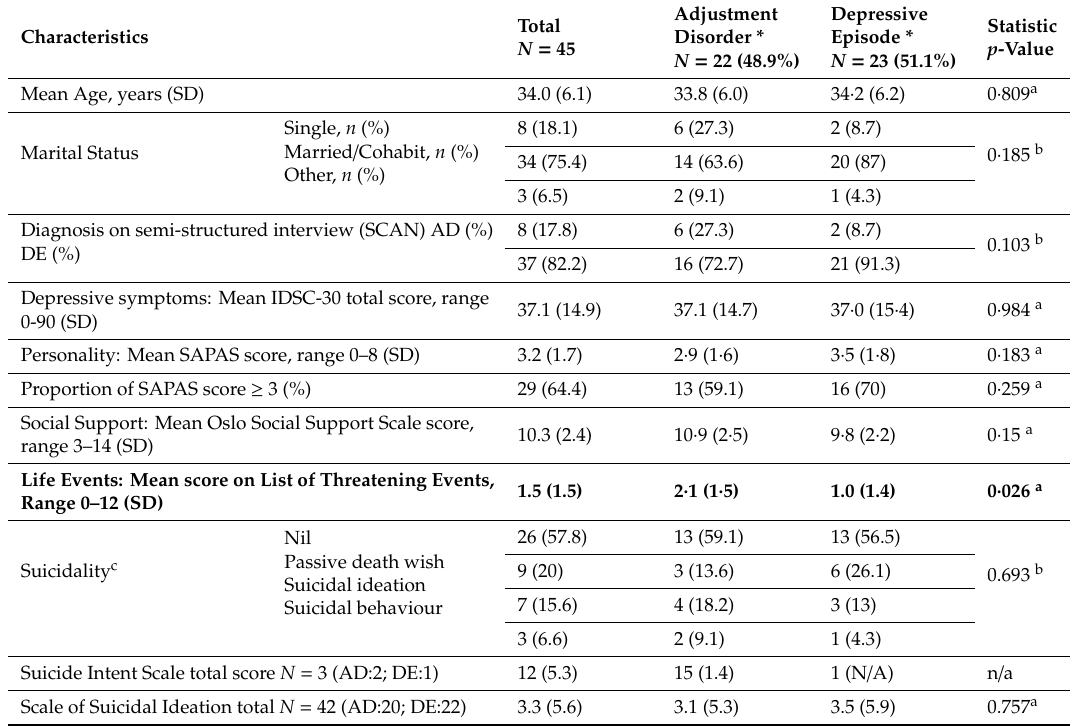
Table 1. Demographic and clinical characteristics in the perinatal population—women recruited in the perinatal period (pregnancy to 12 months following